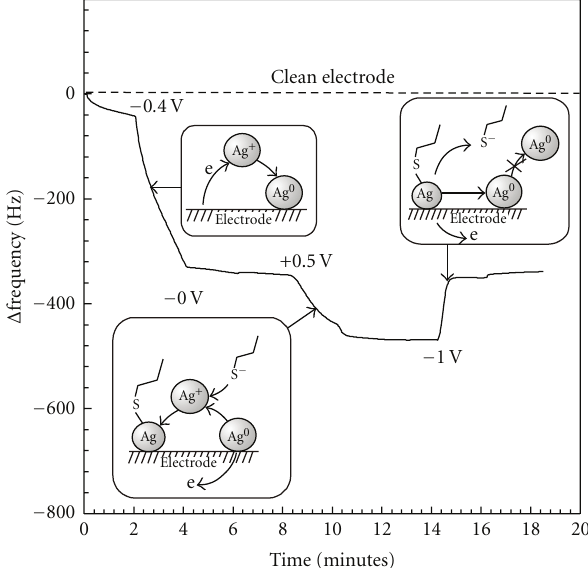
Figure 2: EQCM data highlighting the deposition and stripping of silver in the presence of homocysteine.